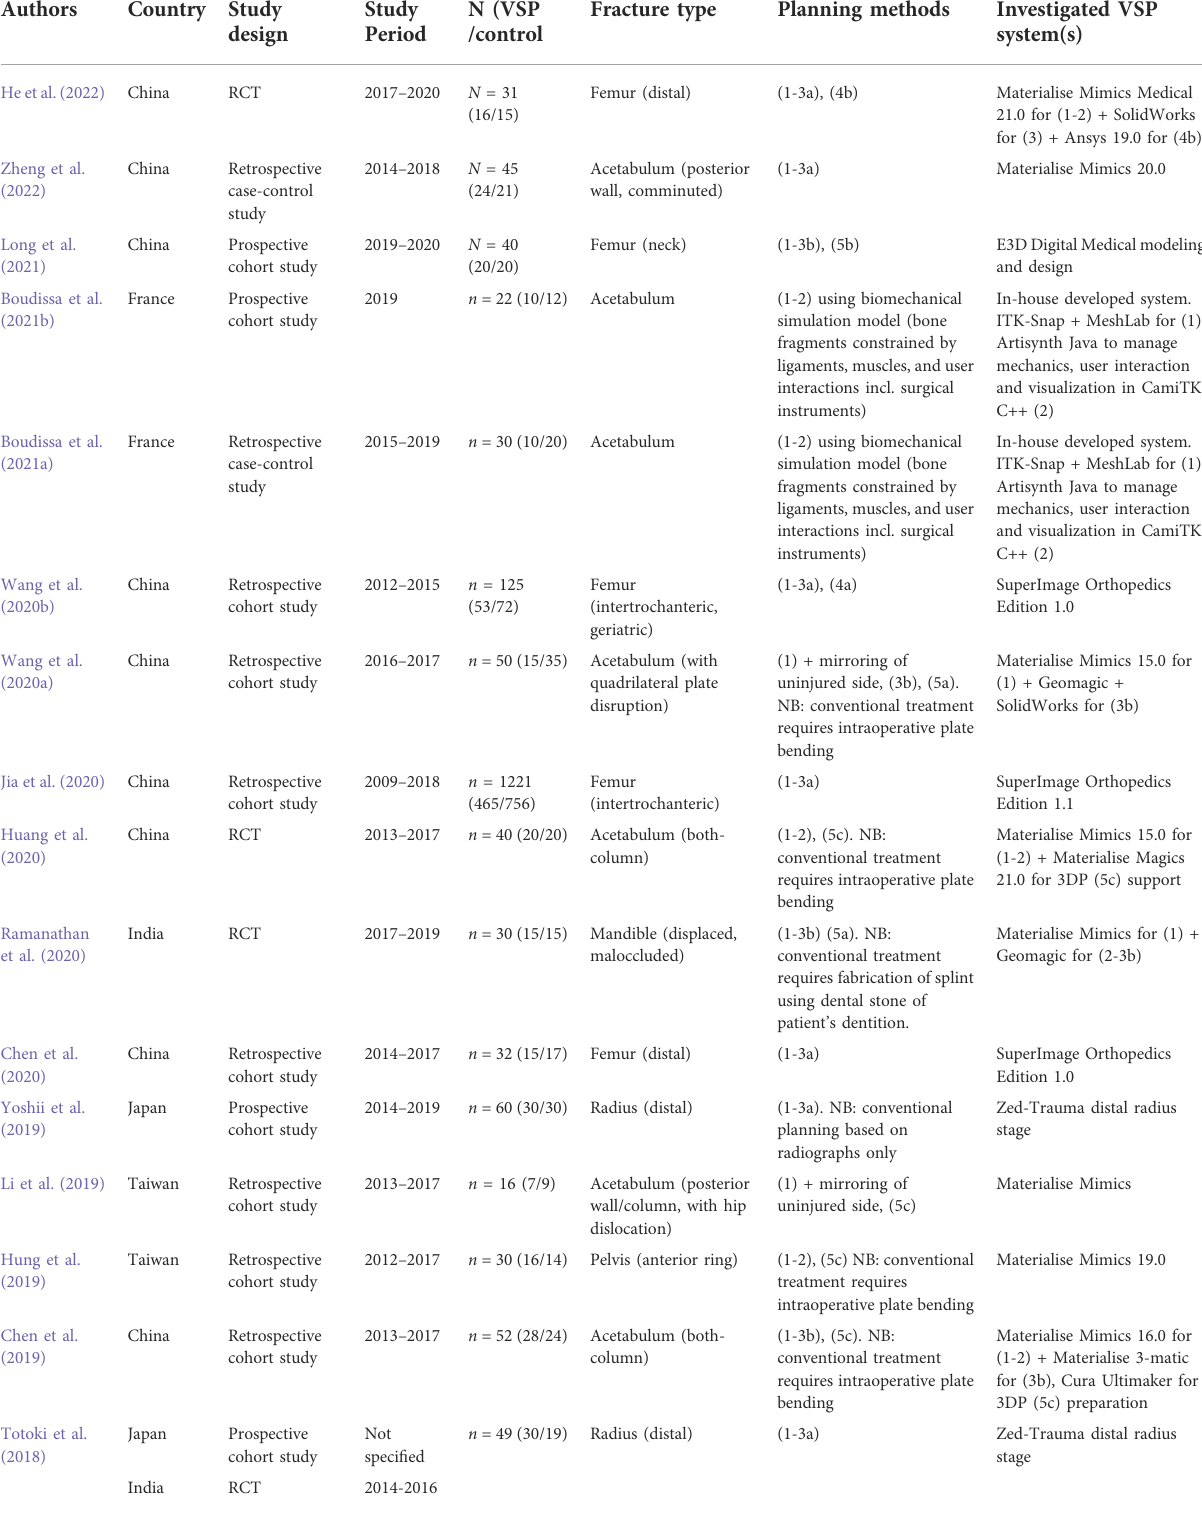
TABLE 2 Study characteristics of included studies with a control group. (1) 3D reconstruction (2) virtual reduction, (3a) virtual fi xation with implant fromlibrary,(3b)virtual fi xationwithCADimplant(4a)Geometricalanalysis,(4b)FEA,(5a)3DprintingofCADimplant,(5b)CADand3Dprintingof guide plates (5c) 3D printing reduced/mirrored bone model +